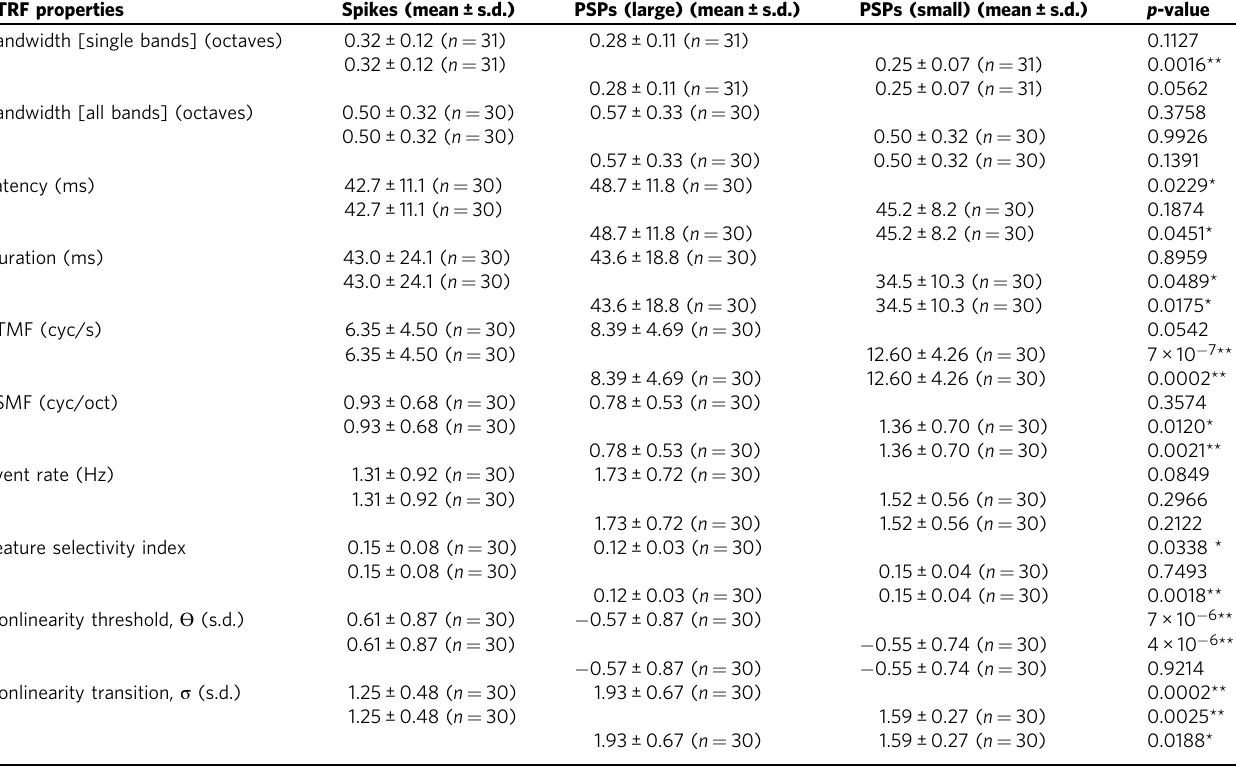
Table 1 Functional properties of spiking and PSP STRFs. STRF properties Spikes (mean ±